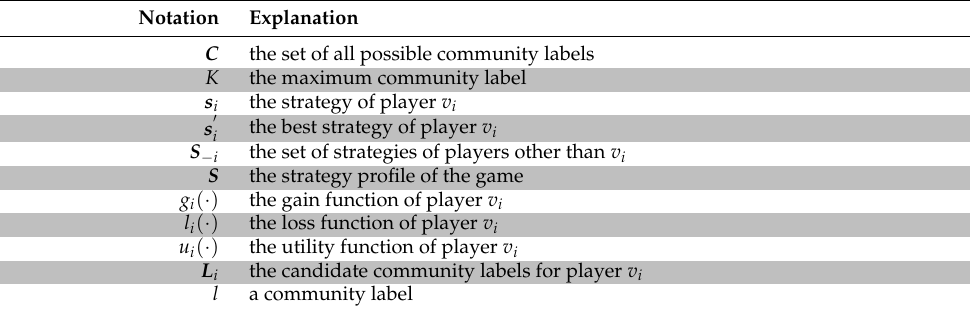
Table 1. Notations of Community Formation